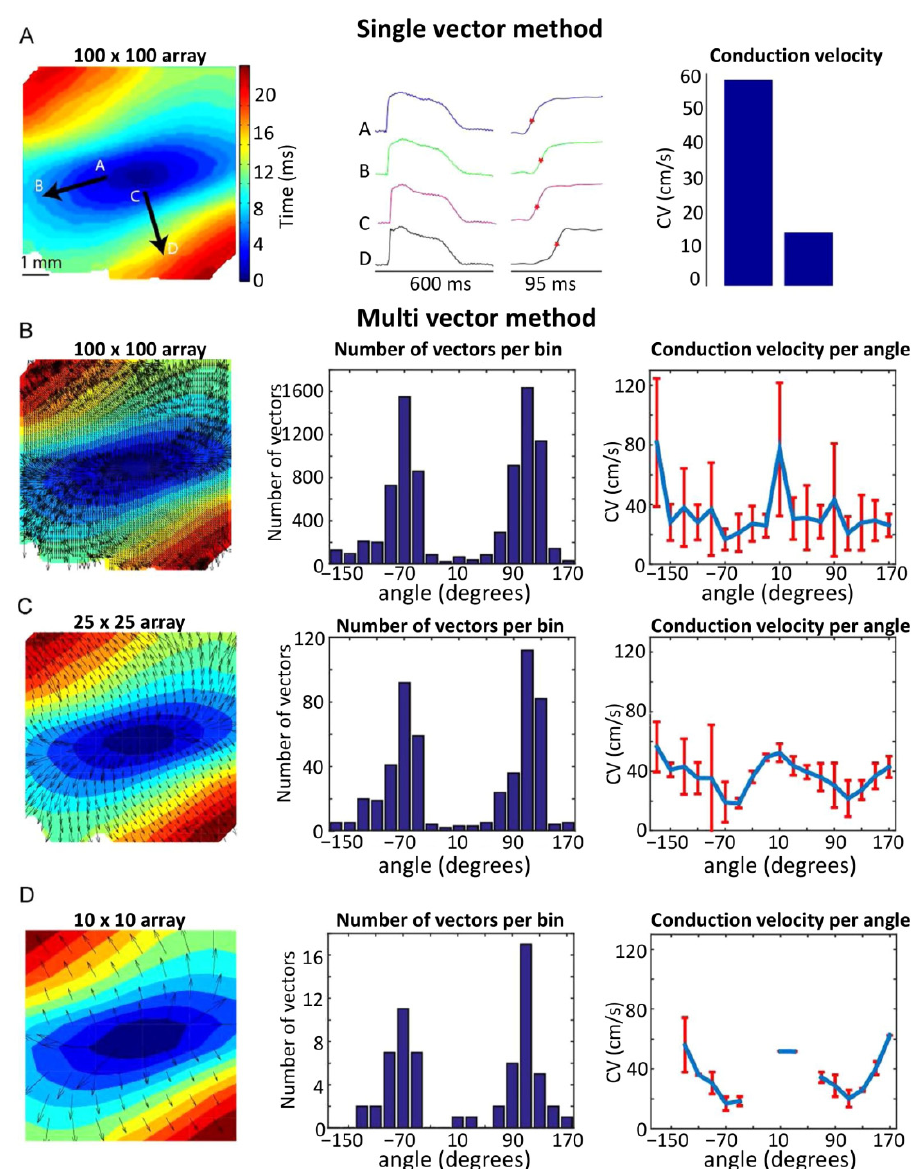
Figure 2. Single- and multi-vector methods for calculating CV. ( A ) (Left panel) Activation map opti- cally recorded from the sub-epicardium of a left ventricular wedge preparation from a human heart during central point-stimulation. Black arrows indicate the directions in which either longitudinal (A–B arrow) or transverse (C–D arrow) CV was measured. (Middle panel) Optically recorded AP from the regions indicated on the activation map, with activation times (time of fastest action poten- tial upstroke) noted. (Right panel) Longitudinal and transversal CV, measured using the single-vector method. ( B ) (Left panel) Activation map of A with superimposed vectors, as calculated by the multi- vector method using 100 × 100 individual analysis regions (Middle panel). Histogram indicating the number of vectors per direction. (Right panel) Average CV for each direction, calculated using the multi-vector method. ( C , D ) show data as in B, but for a 25 × 25 array and a 10 × 10 array, respectively. Reproduced with permission from Doshi, A.N. et al. Feasibility of a semi-automated method for cardiac conduction velocity analysis of high-resolution activation maps. Comput.